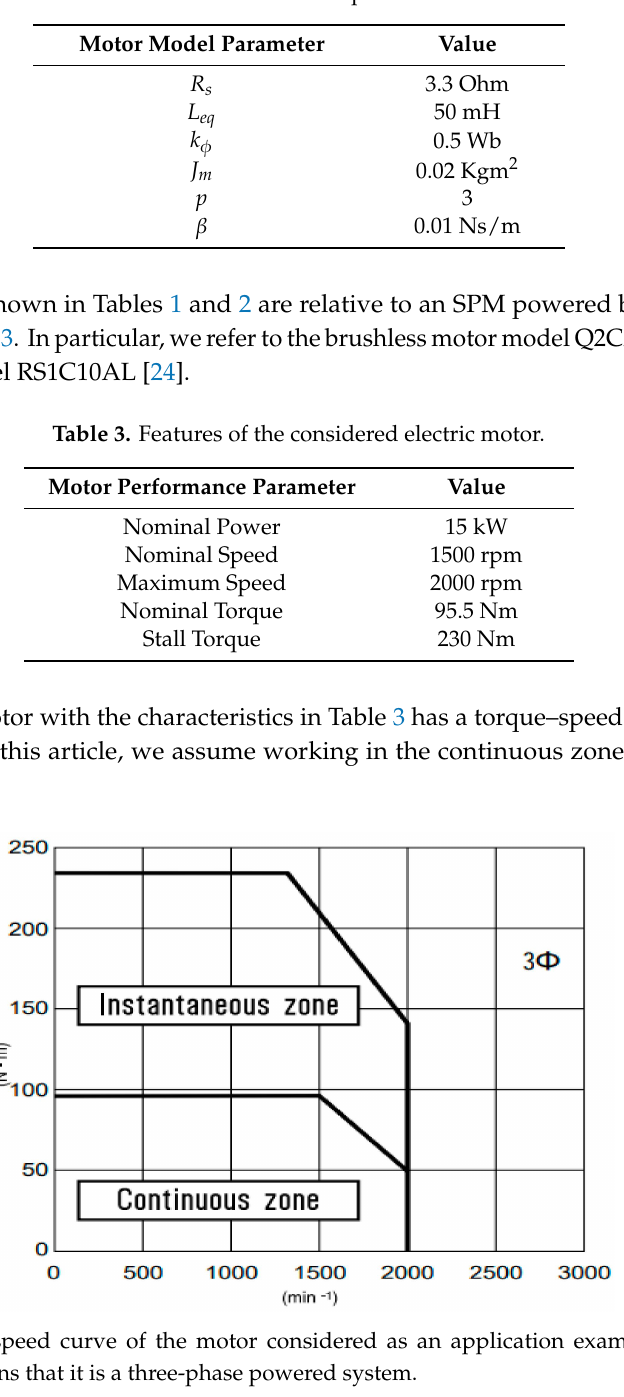
Table 2. Motor model parameters.